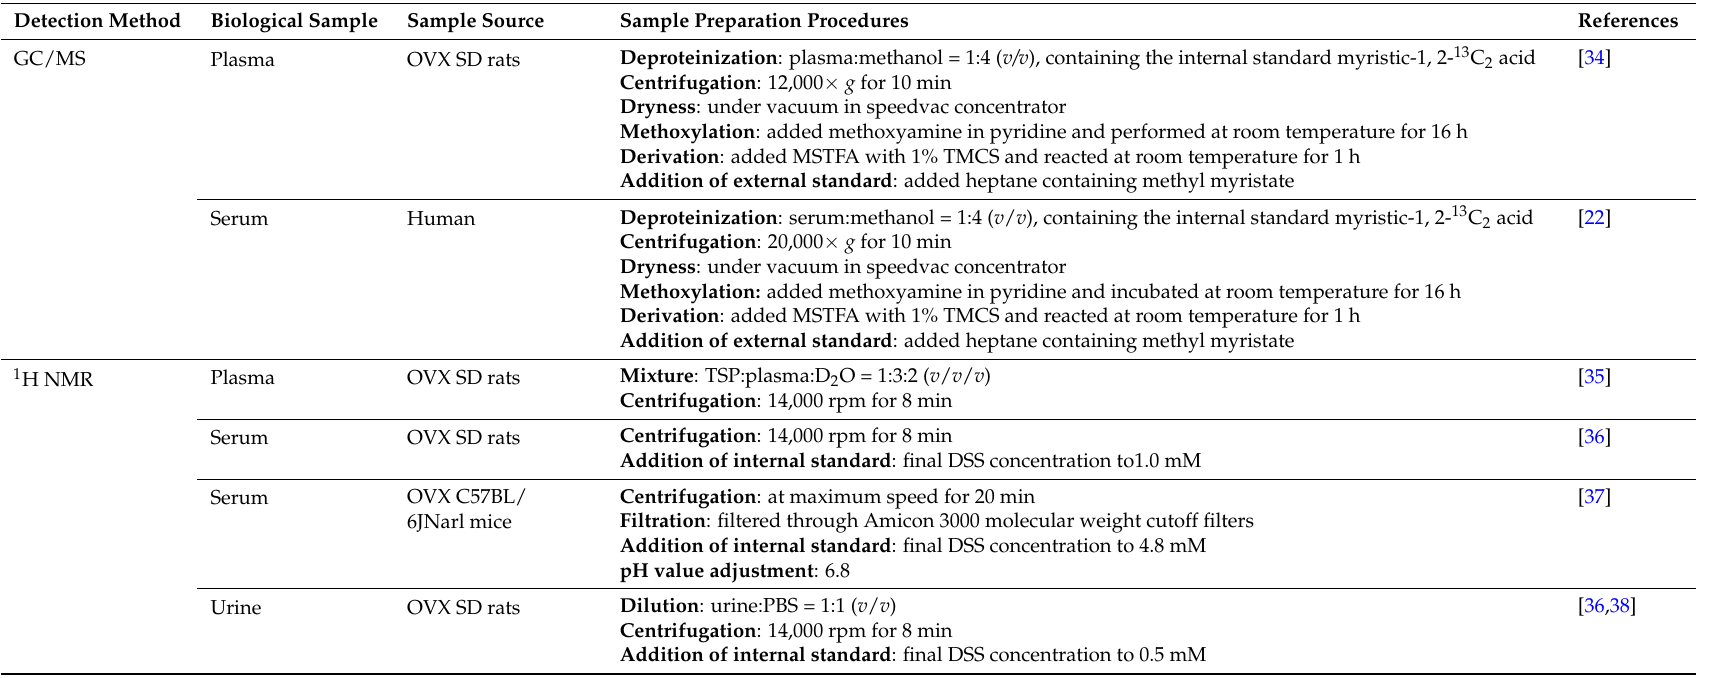
Table 1. The sample preparation procedures for GC/MS, 1 H NMR, and LC/MS analysis in metabolomics-based osteoporosis